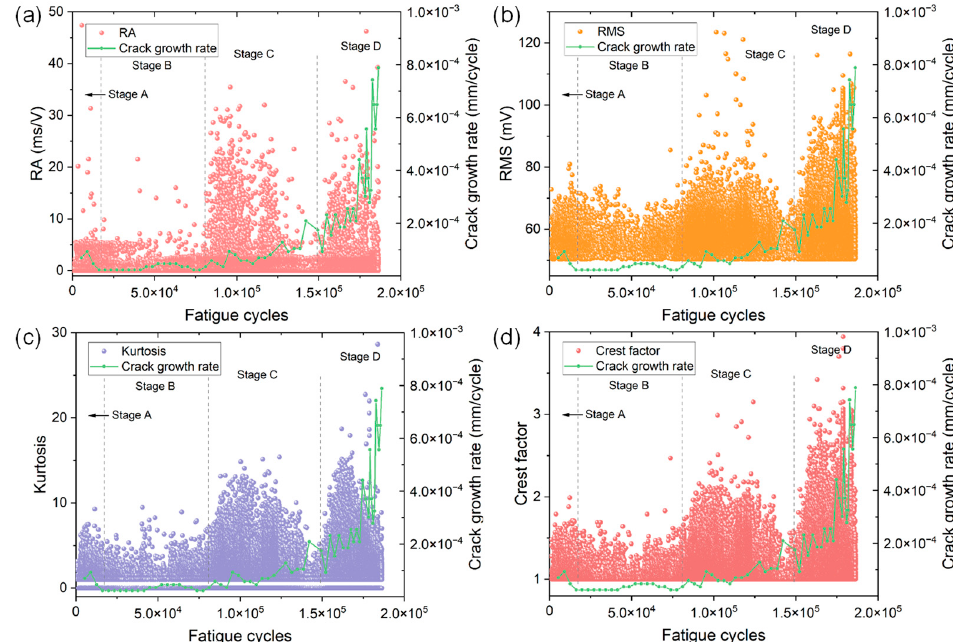
Figure 5. The variations of ( a ) RA value, ( b ) RMS, ( c ) kurtosis and ( d ) crest factor versus fatigue cycles of specimen No.1. The change in crack growth rate is also included for understanding the AE behaviors in different stages.